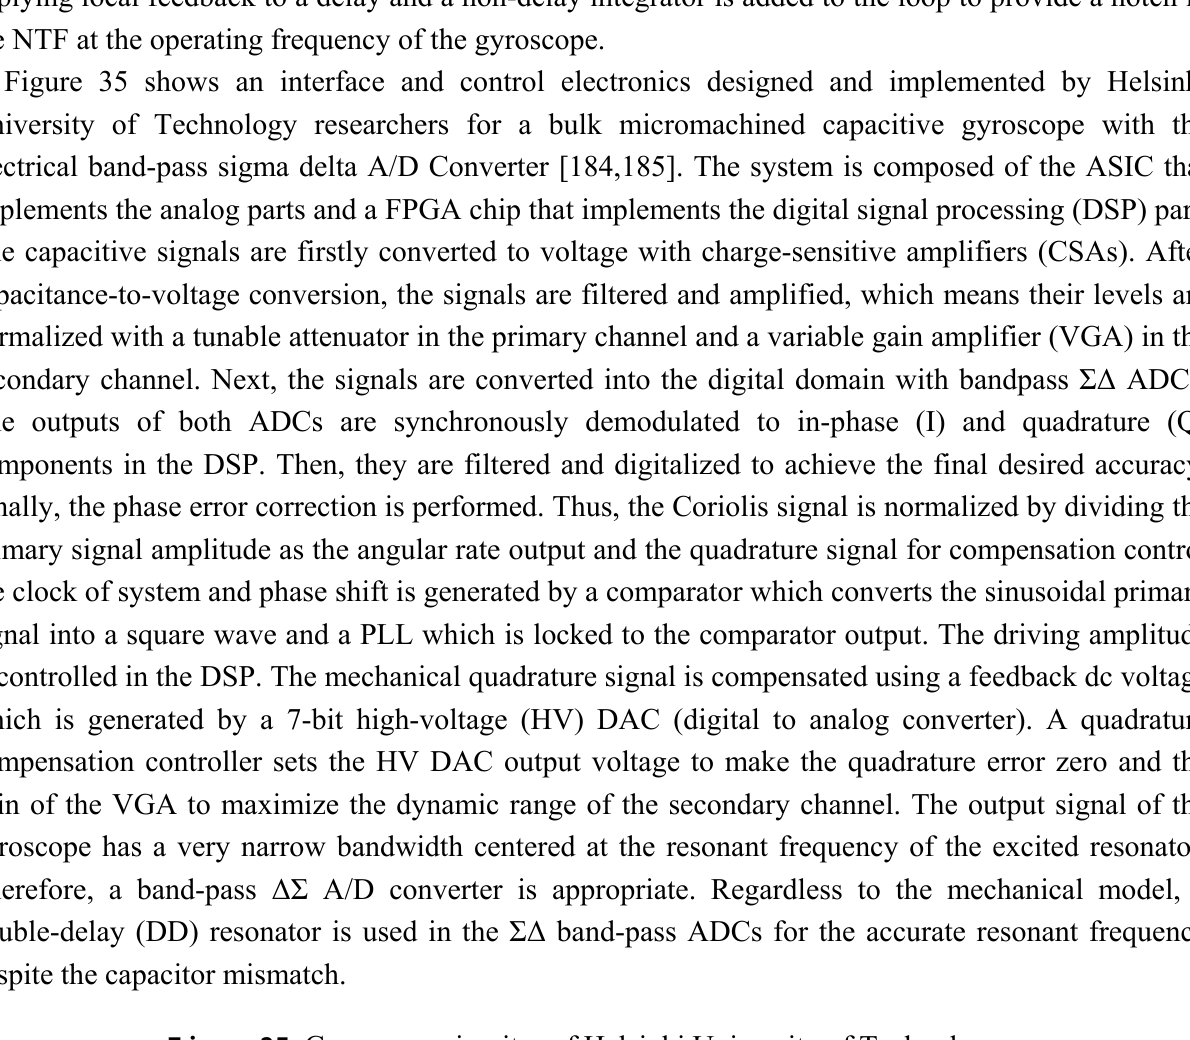
Figure 35. Gyroscope circuitry of Helsinki University of